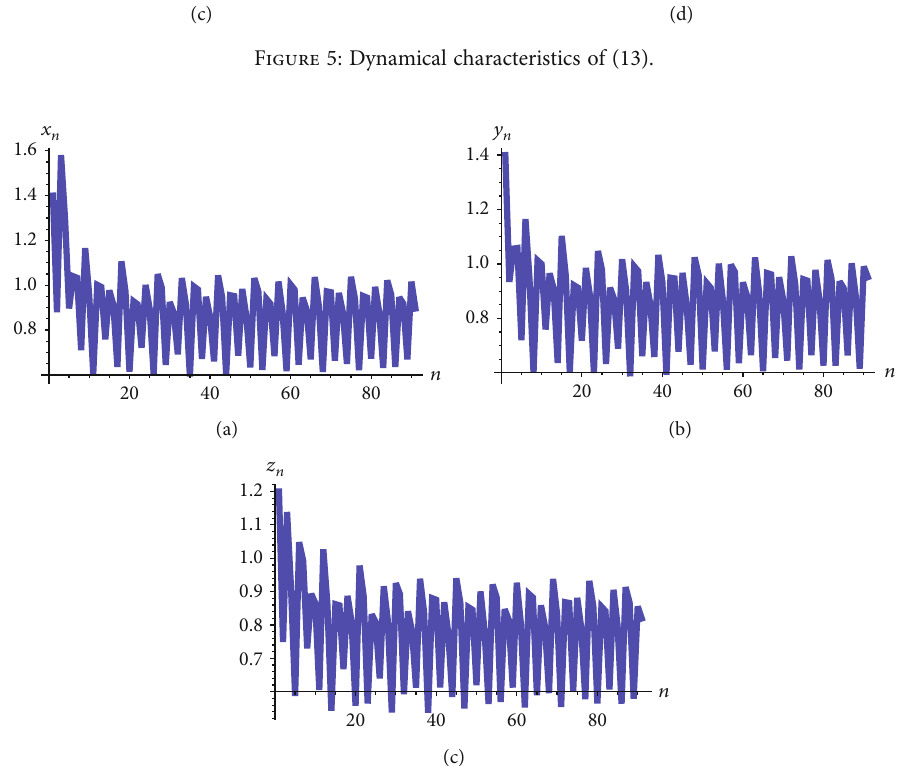
Figure 5: Dynamical characteristics of (13).